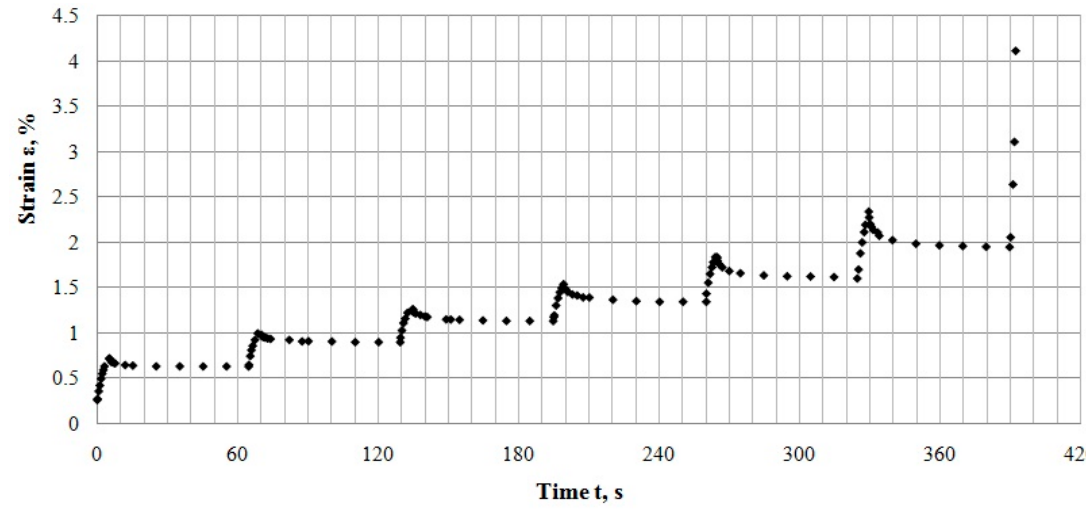
Figure 3. Cyclic strain of asphalt concrete: six full cycles before failure.